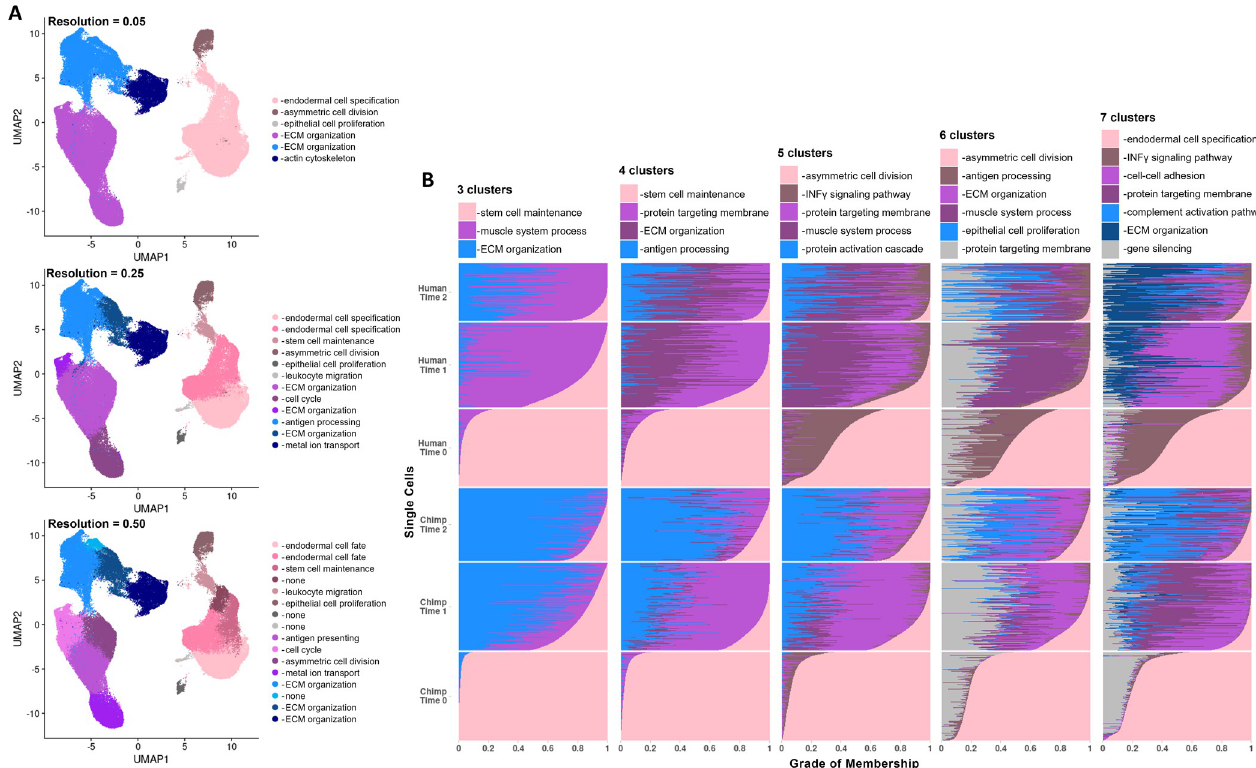
Fig 5. Examining cell types at different resolutions using discrete and continuous perspectives. UMAP dimensional reduction plot of scRNA-seq data with cells labeled by the unsupervised cluster (resolutions of 0.05, 0.25, and 0.50) to which they were assigned (A), and structure plots showing the results of topic modeling at k = 3, k = 4, k = 5, k = 6, and k = 7 with each row representing the gene expression profile from one cell, each colored bar representing a topic, and the grade of membership in each topic depicted by the length of the bar along the x-axis (B). In the structure plots, cells are grouped by their species of origin and collection time point. In both sets of plots, the key notes the top GO category enrichment of marker genes for a given cluster or topic.